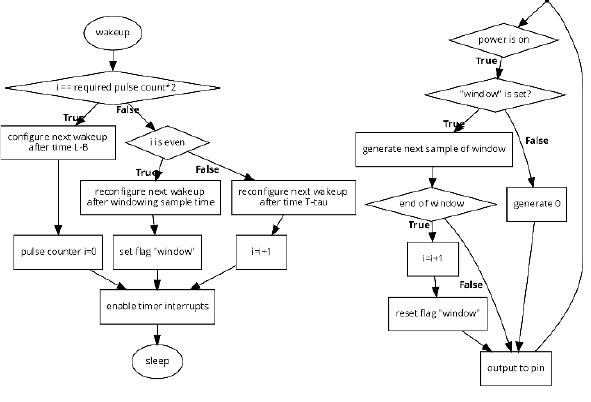
Fig. 5. Setup for testing of acoustic signal transmission in the